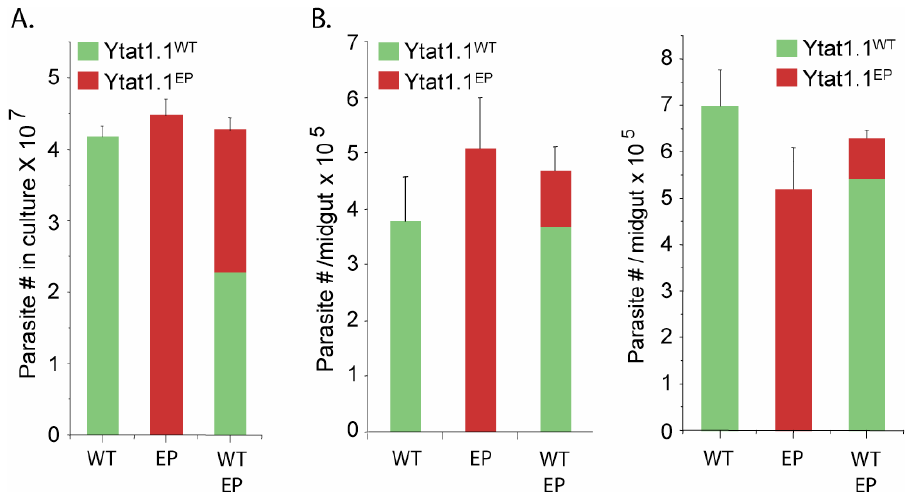
Figure 3. Growth dynamics of YTat1.1 WT and YTat1.1 EP trypanosomes invitro and invivo . (A) In vitro culture densities (average of three separate experiments) maintained alone or as mixed cultures. Red bars denote RFP-YTat1.1 EP and green bars denote GFP-YTat1.1 WT . (B) Concentration of parasites within parasite infected midgut either with one strain alone or as mixed infections. Each group had 6–8 infected midguts and results from two independent experiments are shown.